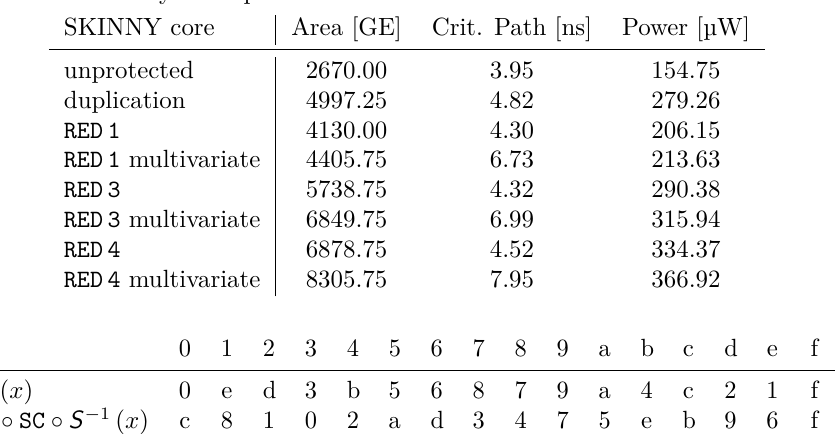
Table 1: Post-layout implementation details of the different SKINNY